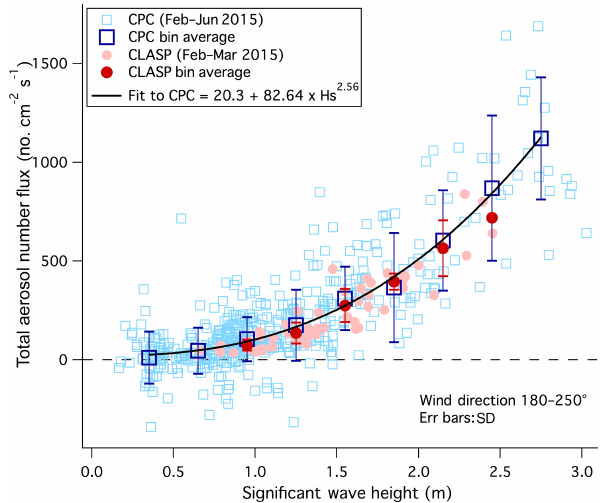
Figure 7. Hourly total aerosol number source fluxes from the CPC and CLASP vs. wave Reynolds number (log scale; data from 2015). Also shown are a linear fit to the CPC fluxes and the Reynolds num- ber parameterization from Norris et al. (2013b, integrated over all CLASP size